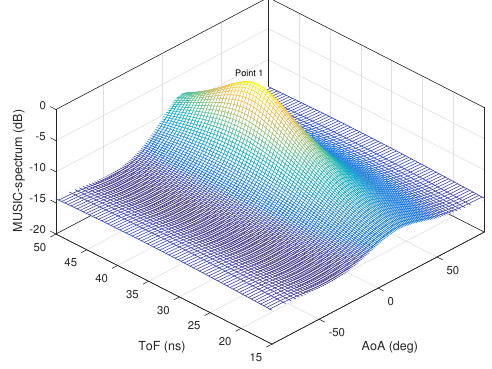
Figure 6. 2D Music spectrum with SNR = 35 dB.